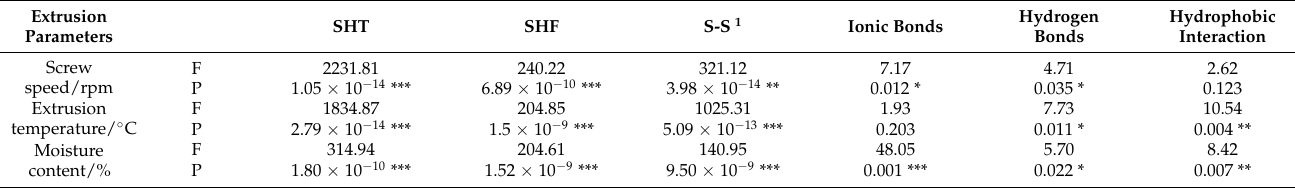
Table 4. One-way ANOVA analysis of the molecular structure of textured rice